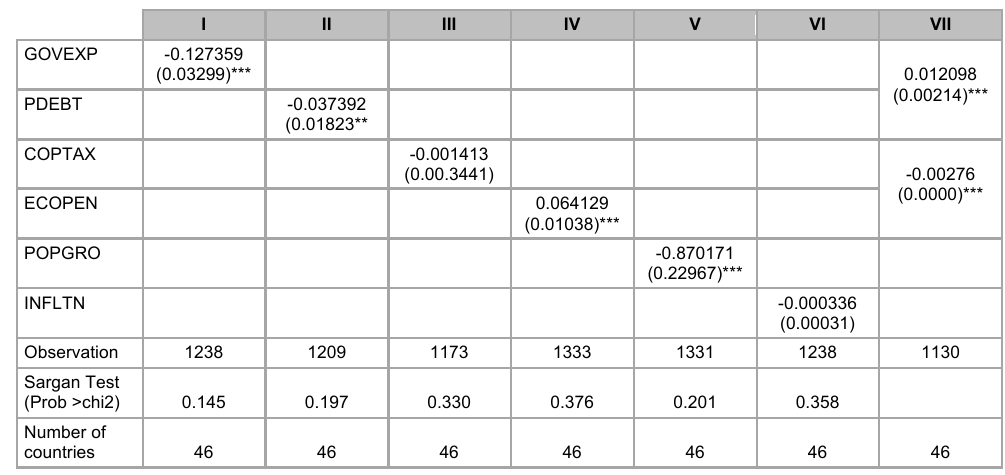
Determinants of FDI flow to Africa (dependent variable –